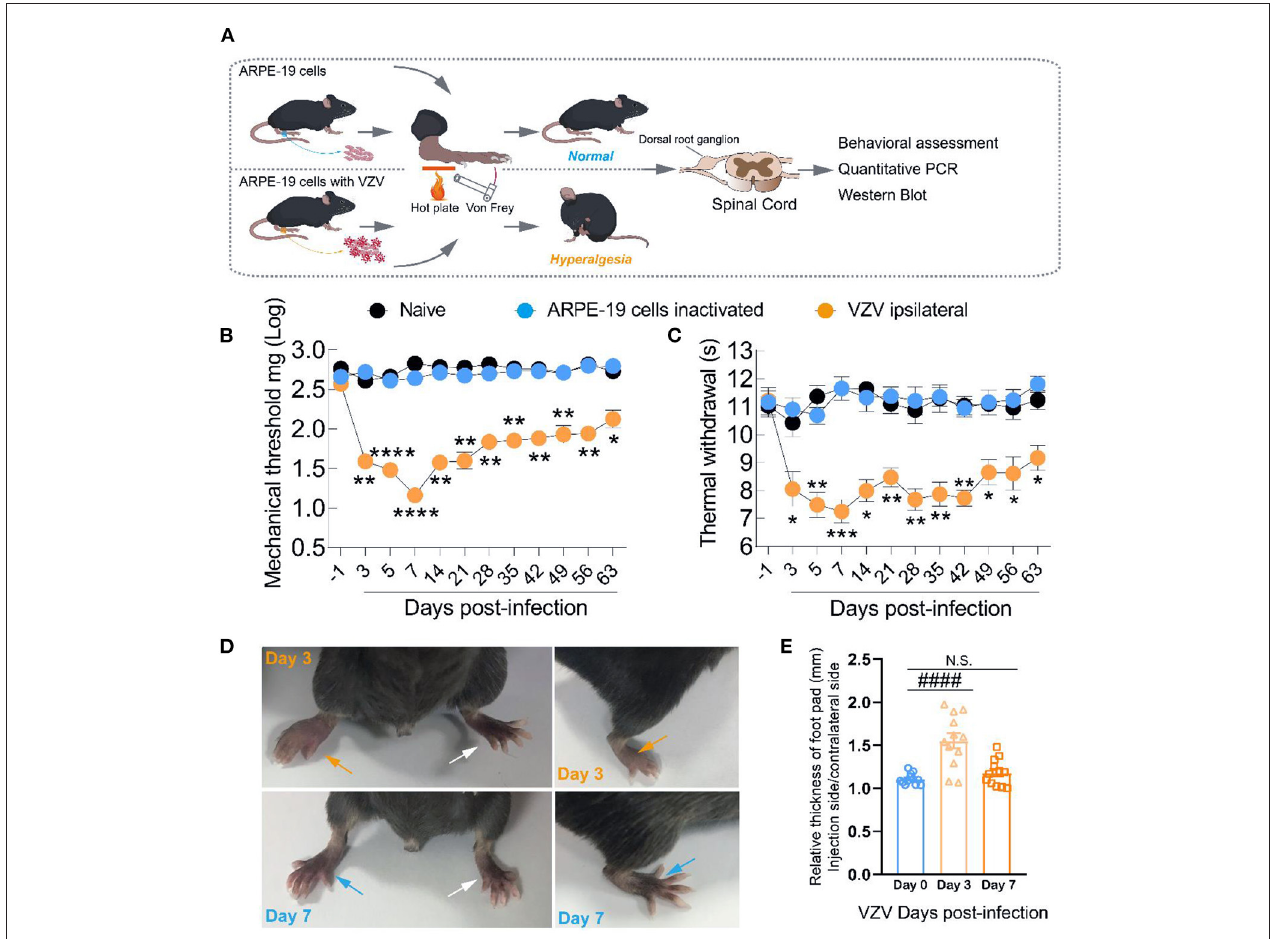
FIGURE 1 | Intraplantar inoculation of varicella-zoster virus (VZV) evoked mechanical and heat hyperalgesia in mice. (A) Schematic of the experimental process. ARPE-19 cells or equivalent ARPE-19 cells with VZV were resuspended with phosphate-buffered saline (PBS) and inoculated into the glabrous region of the right rear footpad of male mice. The mechanical and heat allodynia after cell inoculation were tested with von Frey filaments and a hot plate. (B,C) Time-dependent changes in mechanical allodynia and thermal hyperalgesia of C57BL/6 mice over 63 days after normal control (naïve), inactivated cells, and VZV inoculation, n = 6. (D) Representative microphotographs of the inoculated and contralateral hind paws on days 3 and 7 after VZV inoculation. (E) Comparison of paw thickness on day 3 and day 7, n = 12. Yellow arrows: ipsilateral hind paws on day 3 after VZV inoculation; blue arrows: ipsilateral hind paws on day 7 after VZV inoculation; white arrows: the contralateral hind paws; * p < 0.05, ** p < 0.01, *** p < 0.001, **** p < 0.0001, compared with APPE-19 cells inactivated; #### p < 0.0001, compared with before VZV